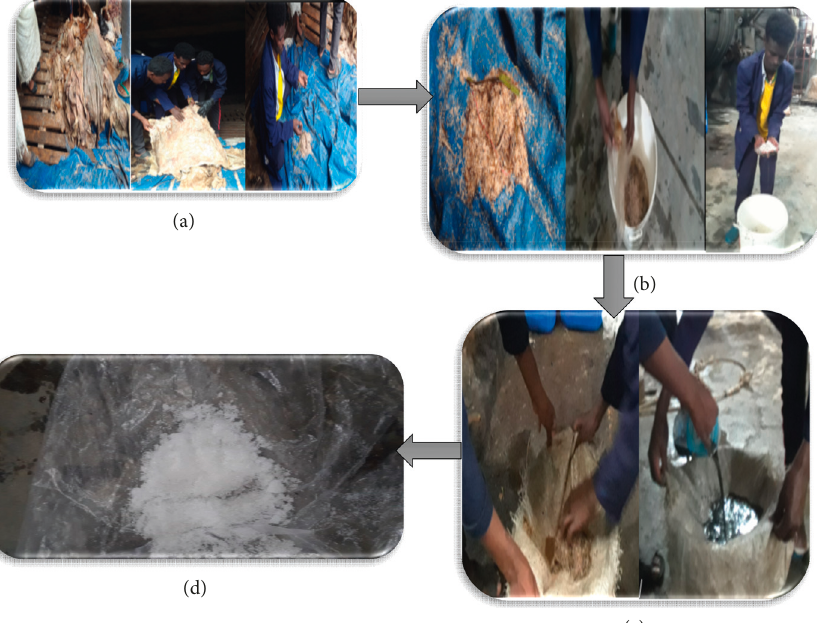
Figure 1: Salt recycling process. The steps followed include (a) desalting, (b) dilution process, (c) filtration, treatment, and drying, and (d) recycled salt. Table 2: Materials specification and recipe development. Sample code